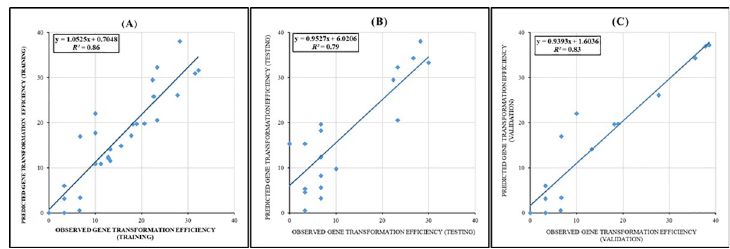
Fig 1. Scatter plot of model predicted vs. observed data of chrysanthemum gene transformation efficiency by ensemble model. (A) Training set, (B) Testing set, and (C) Validation set.